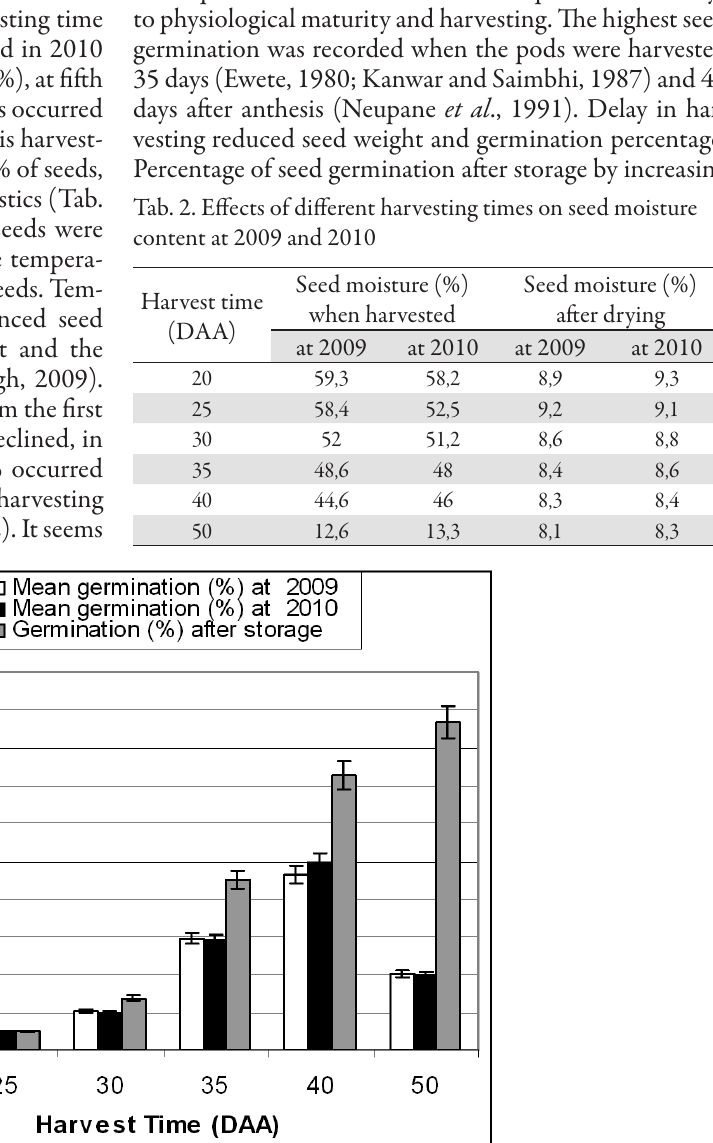
Fig. 1. Effect of different harvesting times and seed storage on mean germination in 2009 and